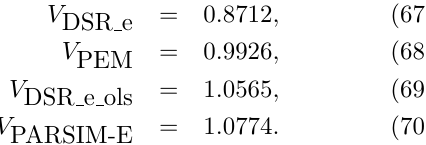
Figure 5: Elements in the deterministic gain matrix, h d = D ( I 3 − A ) B , estimates of the closed loop system in Example 7.2. Both PEM and DSR e ols estimates are illustrated and the correct gains indicated with solid lines.